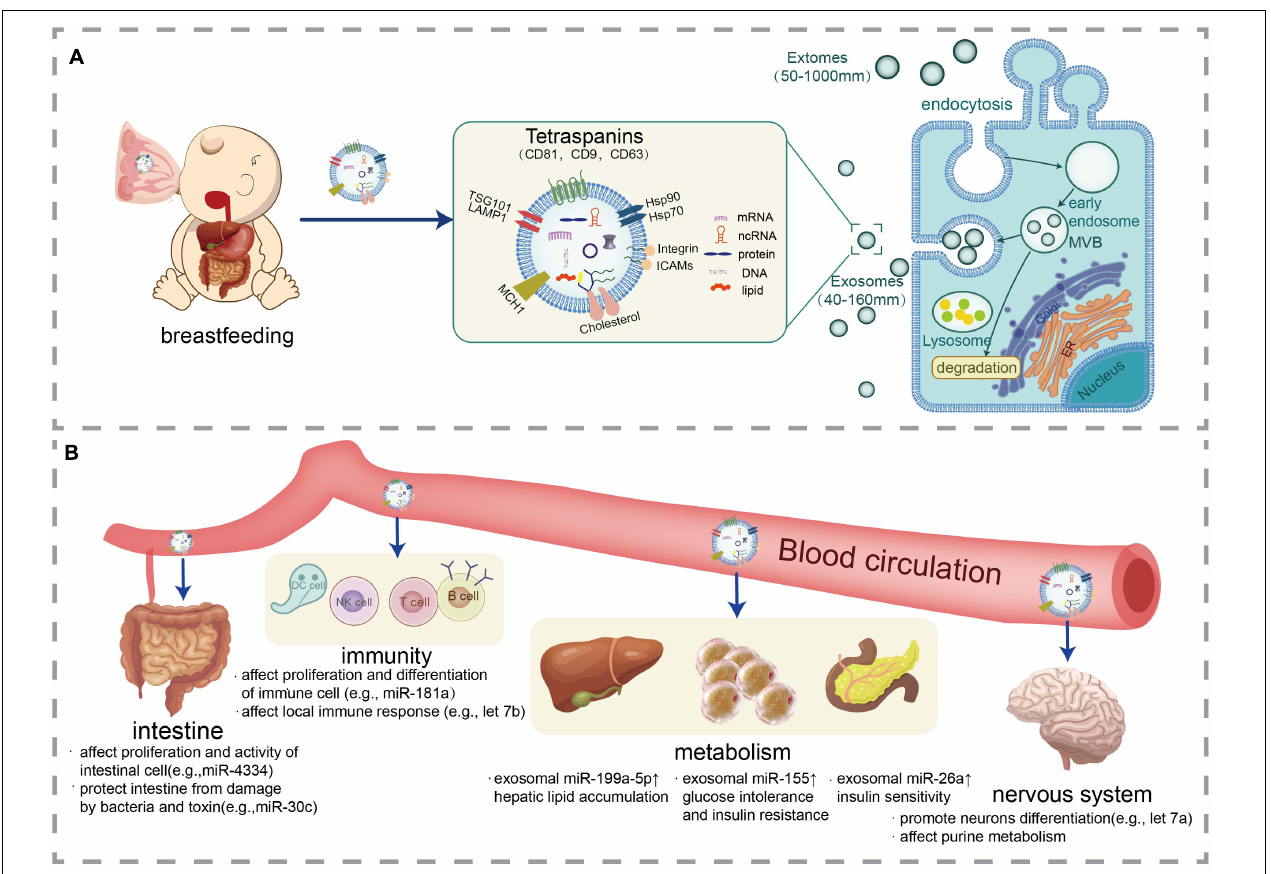
FIGURE 1 | Synthesis, secretion, transport, and effects of milk-derived EVs. (A) Representation of EVs production from cells including milk and an illustration of EVs especially exosomes structure with their cargos including nucleic acid (mRNA, ncRNA, and DNA), protein, and lipids. (B) EVs are absorbed by the intestinal cells of the infant and are transported to various tissues of the body via blood circulation to exert biological activities including immune regulation, metabolic regulation, and neural